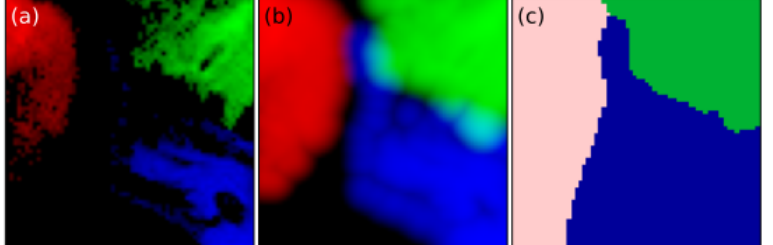
Figure 15. ( a ) The number of pixels assigned to each of the 64 nodes, scaled to the maximum of each class, for water ( blue ), land ( green ), and clouds ( red ), plotted logarithmically. ( b ) The estimated probability that a pixel in a given class is a member of an SOM node, plotted logarithmically with black = 10 − 15 . ( c ) The class labels assigned to each